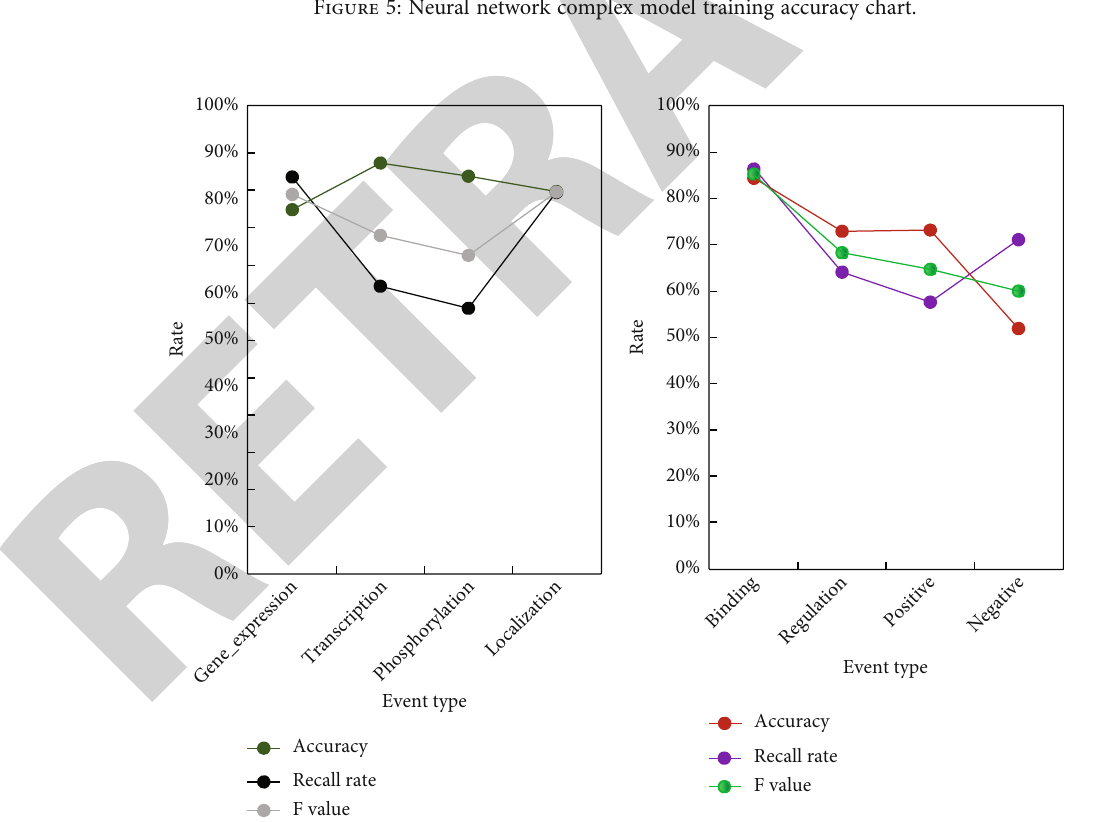
Figure 6: Experimental results of the method in this